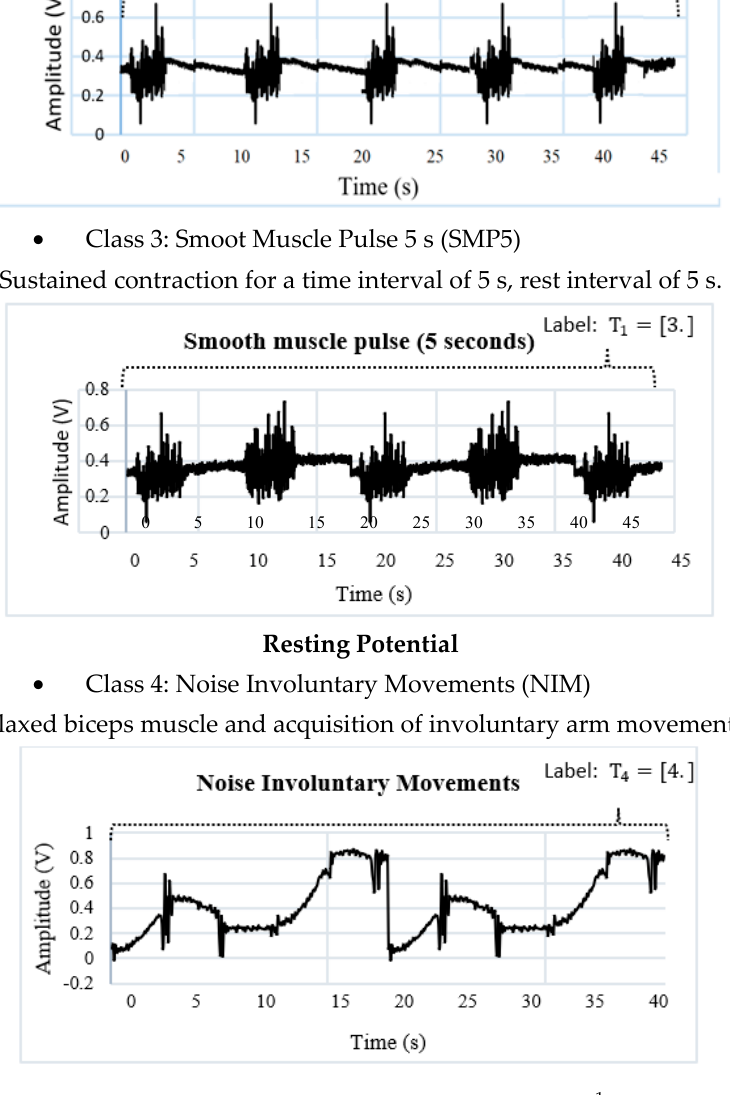
Figure 10. Graphical representation of the data set (input vector p 1 × n ). The output vector T 1 × n stores the labels of each class using integer data.